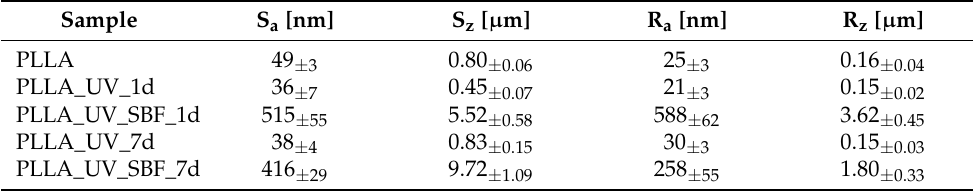
Table 1. Roughness parameters of analyzed samples based on the surface profiles (S a , S z ) and the single line profiles (R a , R z ) shown in Figure 2.